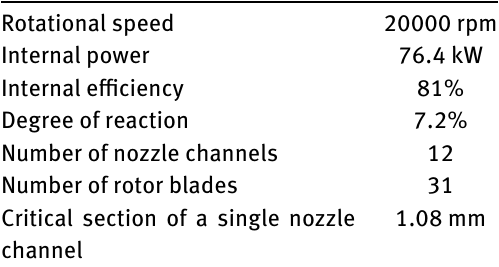
Table 4: General characteristics of the stage.